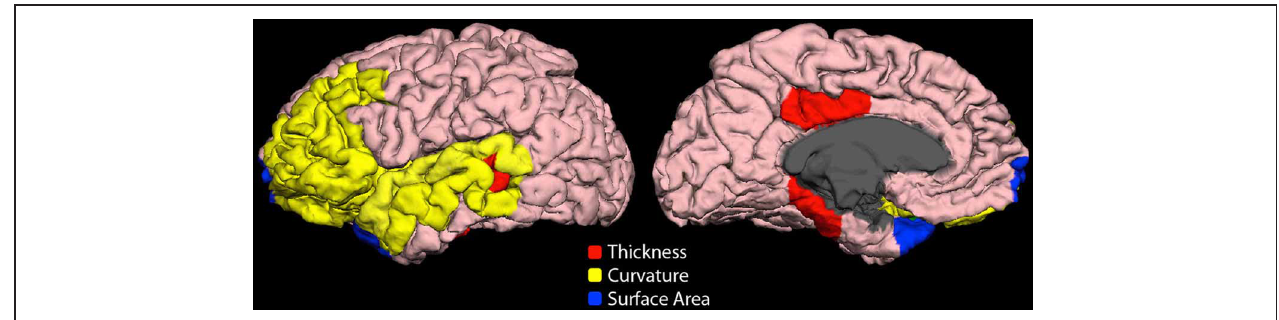
FIGURE 7 | Cortical features (NYU site). Twelve cortical morphological measures were optimally discriminative of class, including cortical thickness (posterior cingulate, parahippocampal, bank of superior temporal sulcus),